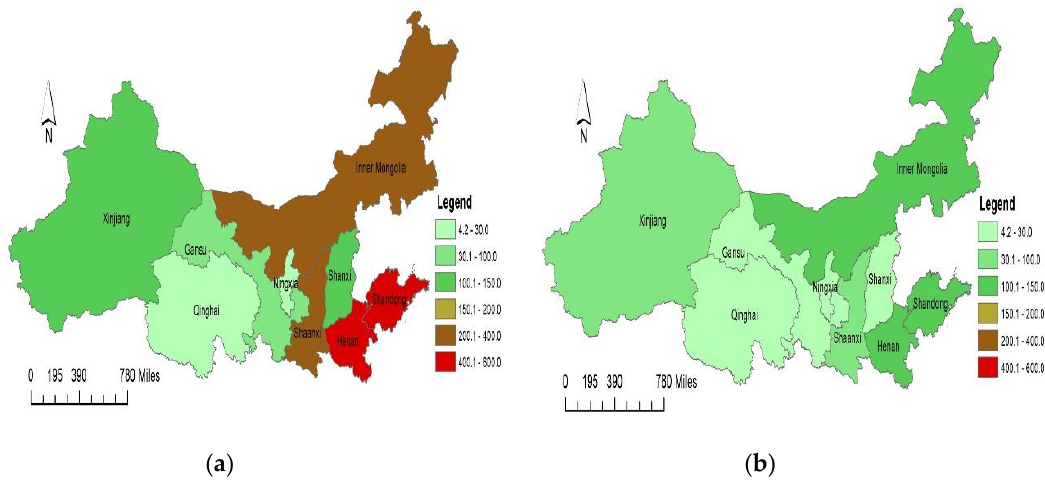
Figure 3. Virtual water inflow of each province in the Yellow River Economic Belt. (left-Inflow within the Yellow River Economic Belt ( a ) and on the right ( b ) Inflow from provinces outside the Yellow River Economic Belt.